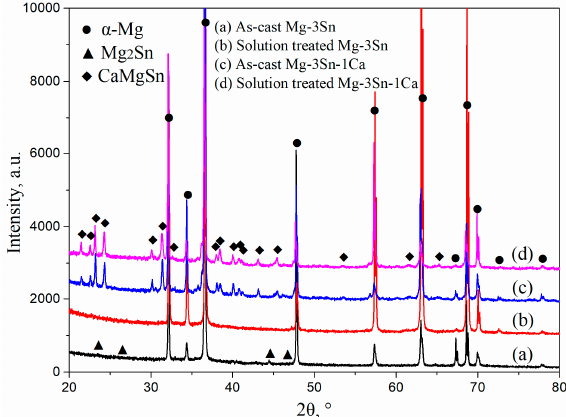
Figure 1. XRD patterns of as-cast ( a , c ) and solution treated ( b , d ) Mg-3Sn and Mg-3Sn-1Ca alloys.